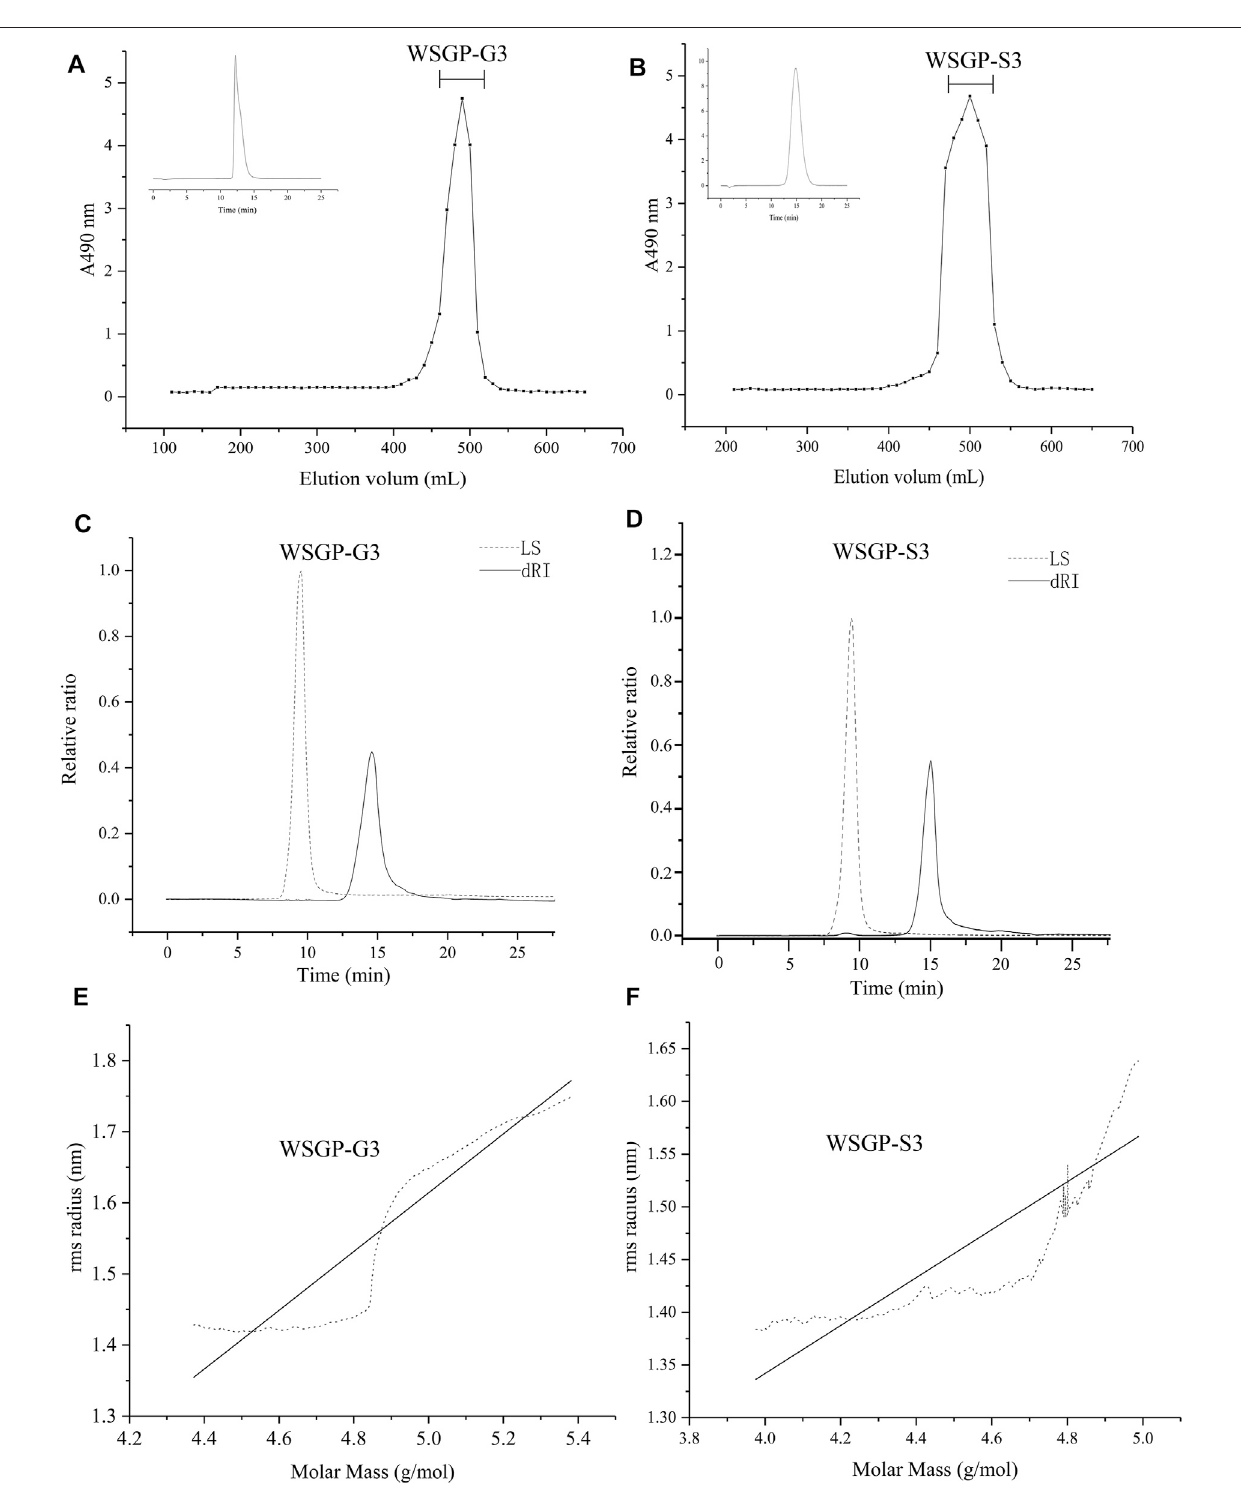
FIGURE1| Gelpermeationchromatographypro fi lesfor: (A) WSGP-G3; (B) WSGP-S3;SEC-MALLSchromatogramsbyMALLSandDRIfor: (C) ofWSGP-G3; (D) WSGP-S3; (C) Plot of log(S2)z 1/2 vs. the log M w for: (E) WSGP-G3; (F) WSGP-S3.